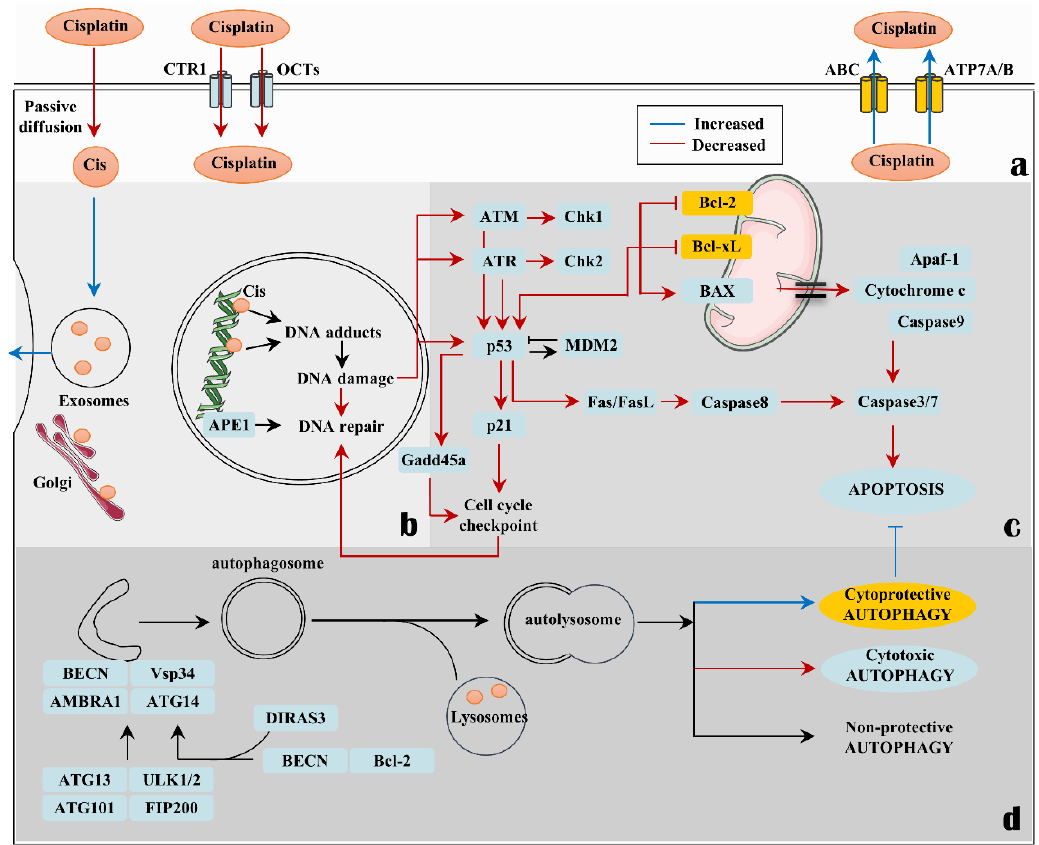
Figure 1. Primary mechanisms of cisplatin resistance. ( a ) Decrease in DNA adduct levels. Inward transport: copper transporter 1 (CTR1) and organic cation transporters (OCTs). Outward transport: ATP-binding cassette (ABC) multidrug transporters (including the multidrug resistance proteins and multidrug resistance-associated protein families). ATP7A/B, which belongs to the copper-transporting P-type ATPase, is the response for delivering copper into the organelles and removing the excess copper out of cells. ( b ) DNA damage recognition defects and increased DNA damage tolerance. ( c ) Inhibition of apoptosis. ( d ) Induction of cytoprotective autophagy. APE1: apurinic/apyrimidinic endonuclease 1; ATM: ataxia telangiectasia mutated protein; ATR: ataxia telangiectasia and RAD3-related protein; AMBRA1: activating molecule in Beclin1-regulated autophagy.